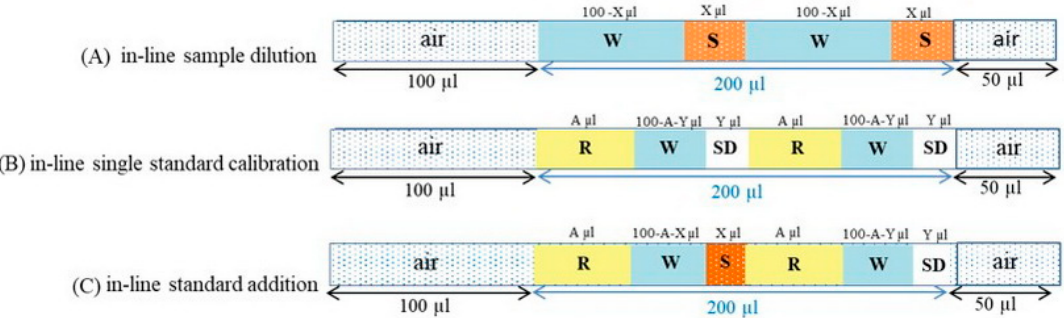
Figure 5. Schematic diagram of the sequential injection lab-at-valve (SI-LAV).